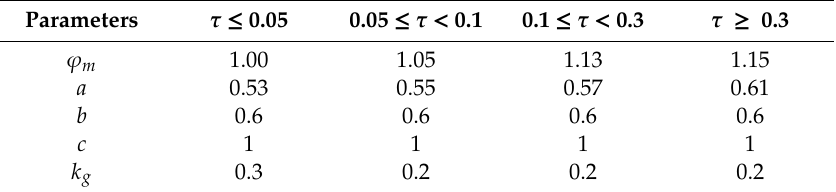
Table 1. The recommended parameters of PID controller for delay robustness-constrained optimization (DRO)